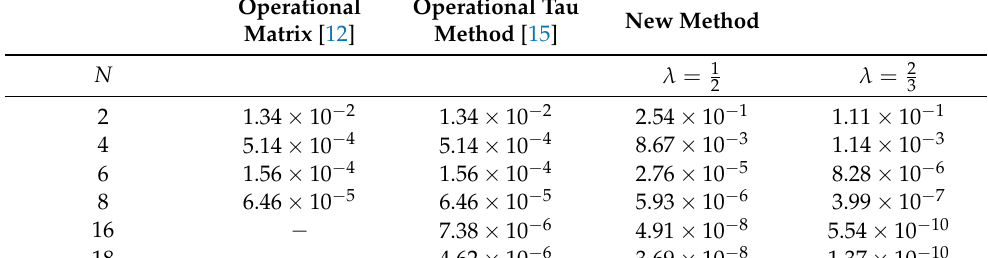
Table 4. The MAE of Example 4 for various values of N , λ = 1 comparison with those obtained in [12,15].